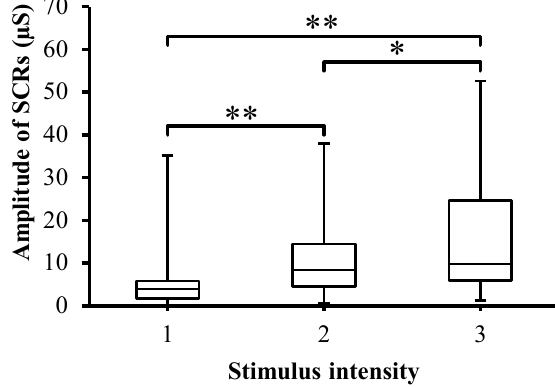
Fig. 1: Box-plot with medians, quartiles and the min and max as whiskers shows value of SCRs_Amp with respect to the stimulus intensity. * p <0.05 and ** p <0.005.